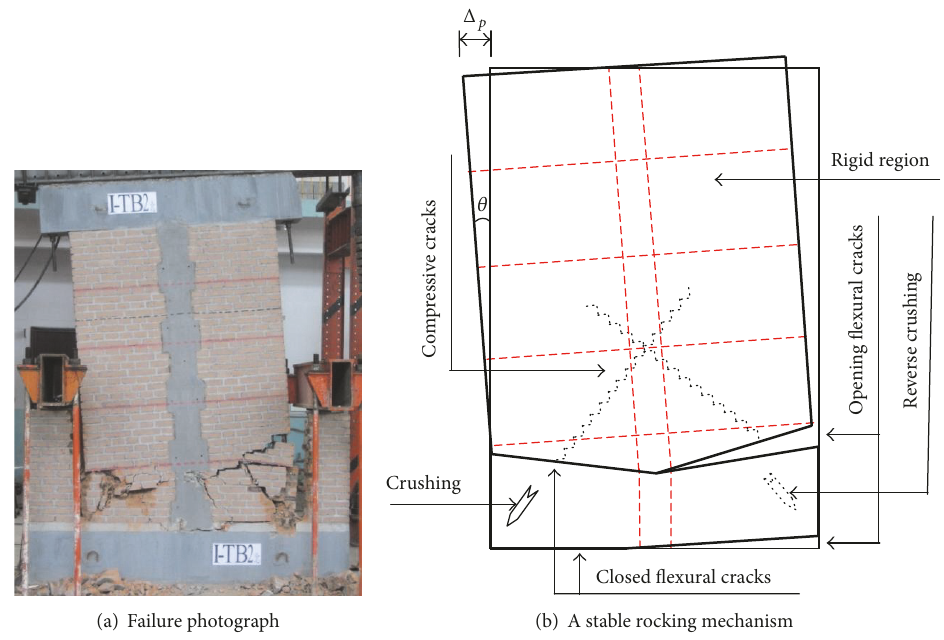
Figure 13: Failure photograph and the rocking mechanism of specimen